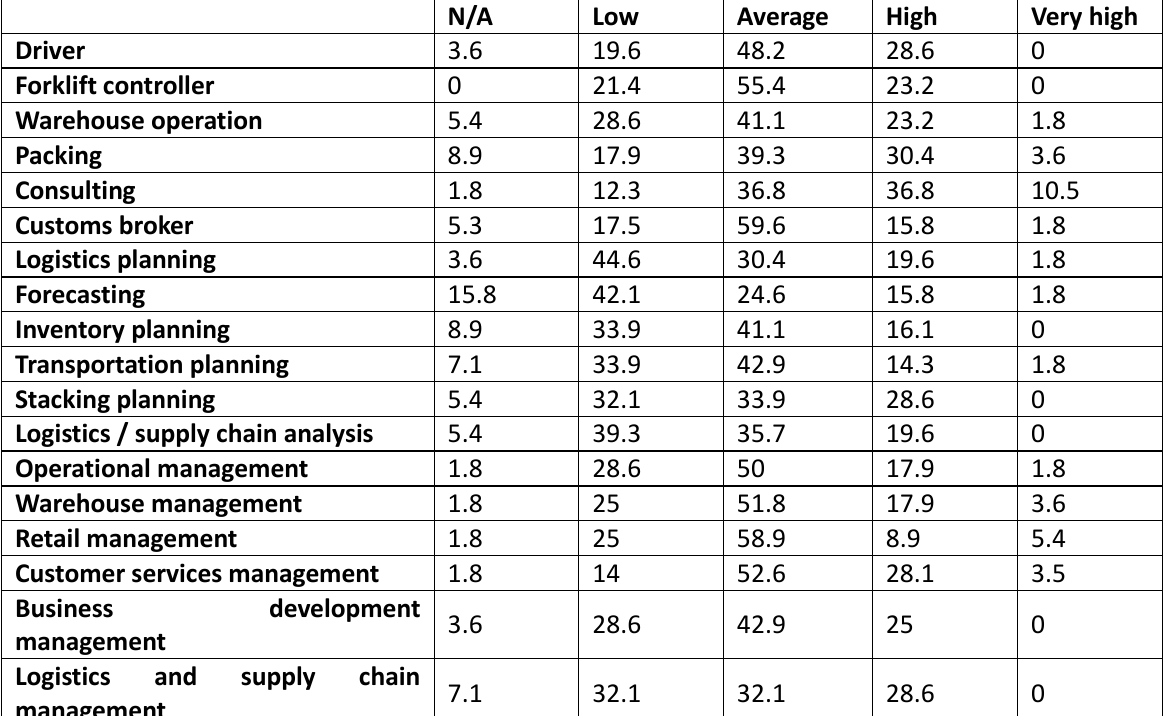
Table 2. The availability of skilled logistics human resources in Vietnam (source: Ministry of Trade and Industry,